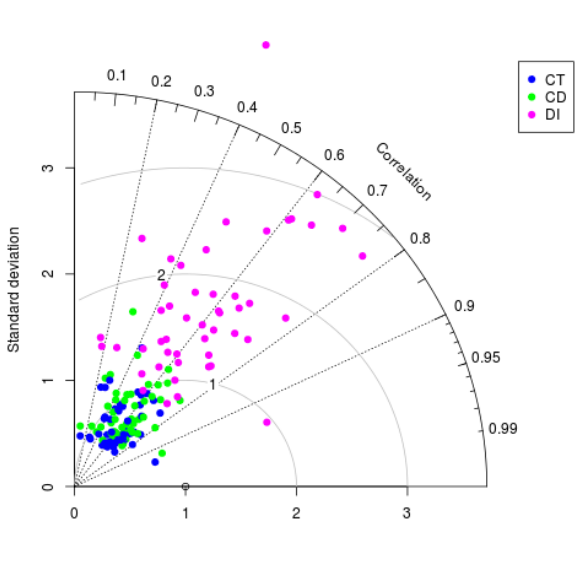
Figure 4. Taylor diagram comparing the retrieved soil moisture from CT, CD and DI model with the field measured soil moisture in 50